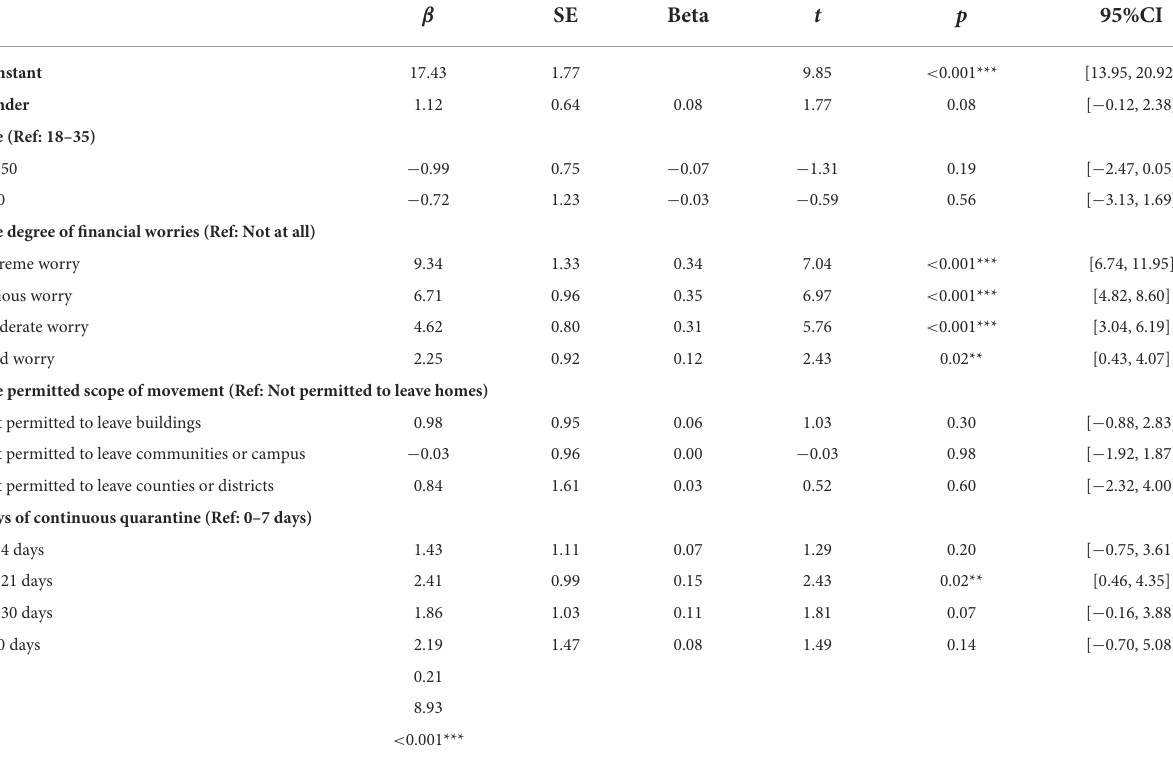
TABLE 2 Multiple linear regression analysis on perceived stress.